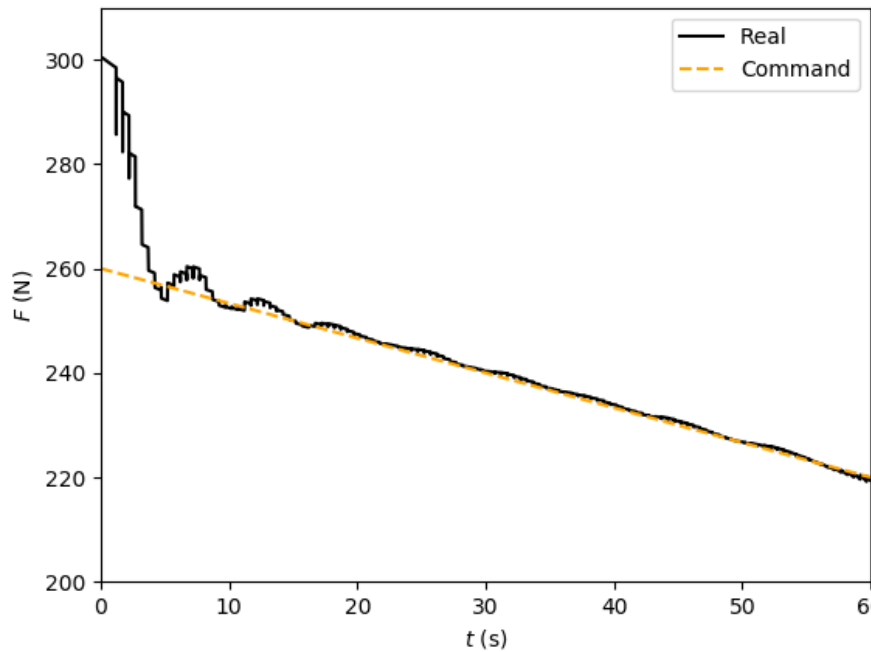
Figure A9. Thrust profile, feedback with downgraded regulation law, case 3.